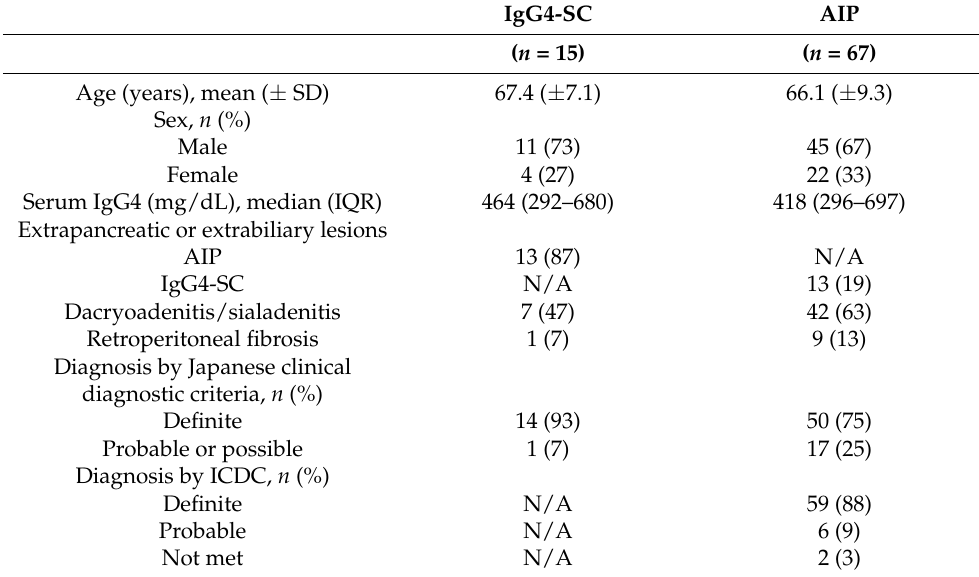
Table 1. Patient characteristics.